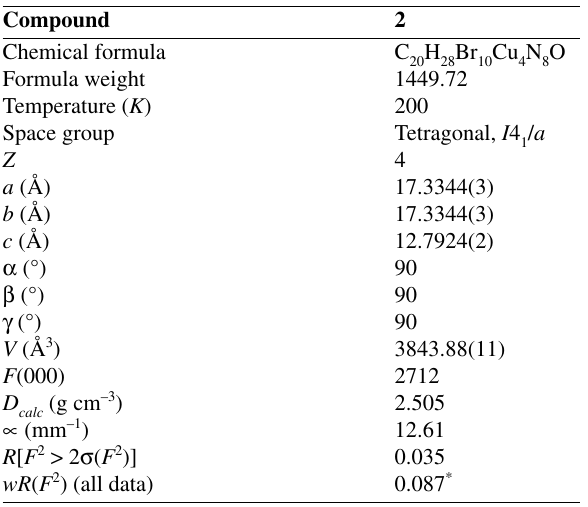
Table 1. Crystallographic data of complex